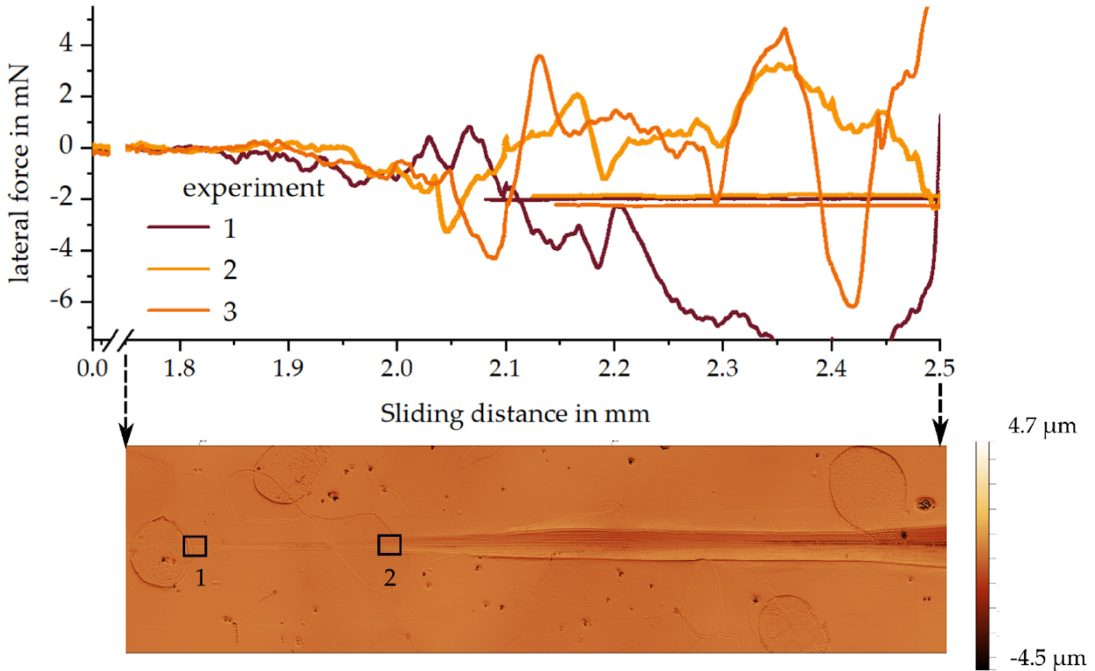
Figure 4. Lateral force of all three experiments in the sliding distance range of 1.5–2.5 mm. The topography of the corresponding wear track length for experiment 3 is shown in the bottom of the figure. The scale of the topography image corresponds to the graph abscissa. The black rectangles indicate the positions of the TEM foils shown in Figure 5b,c. The foils were prepared parallel to the sliding direction.